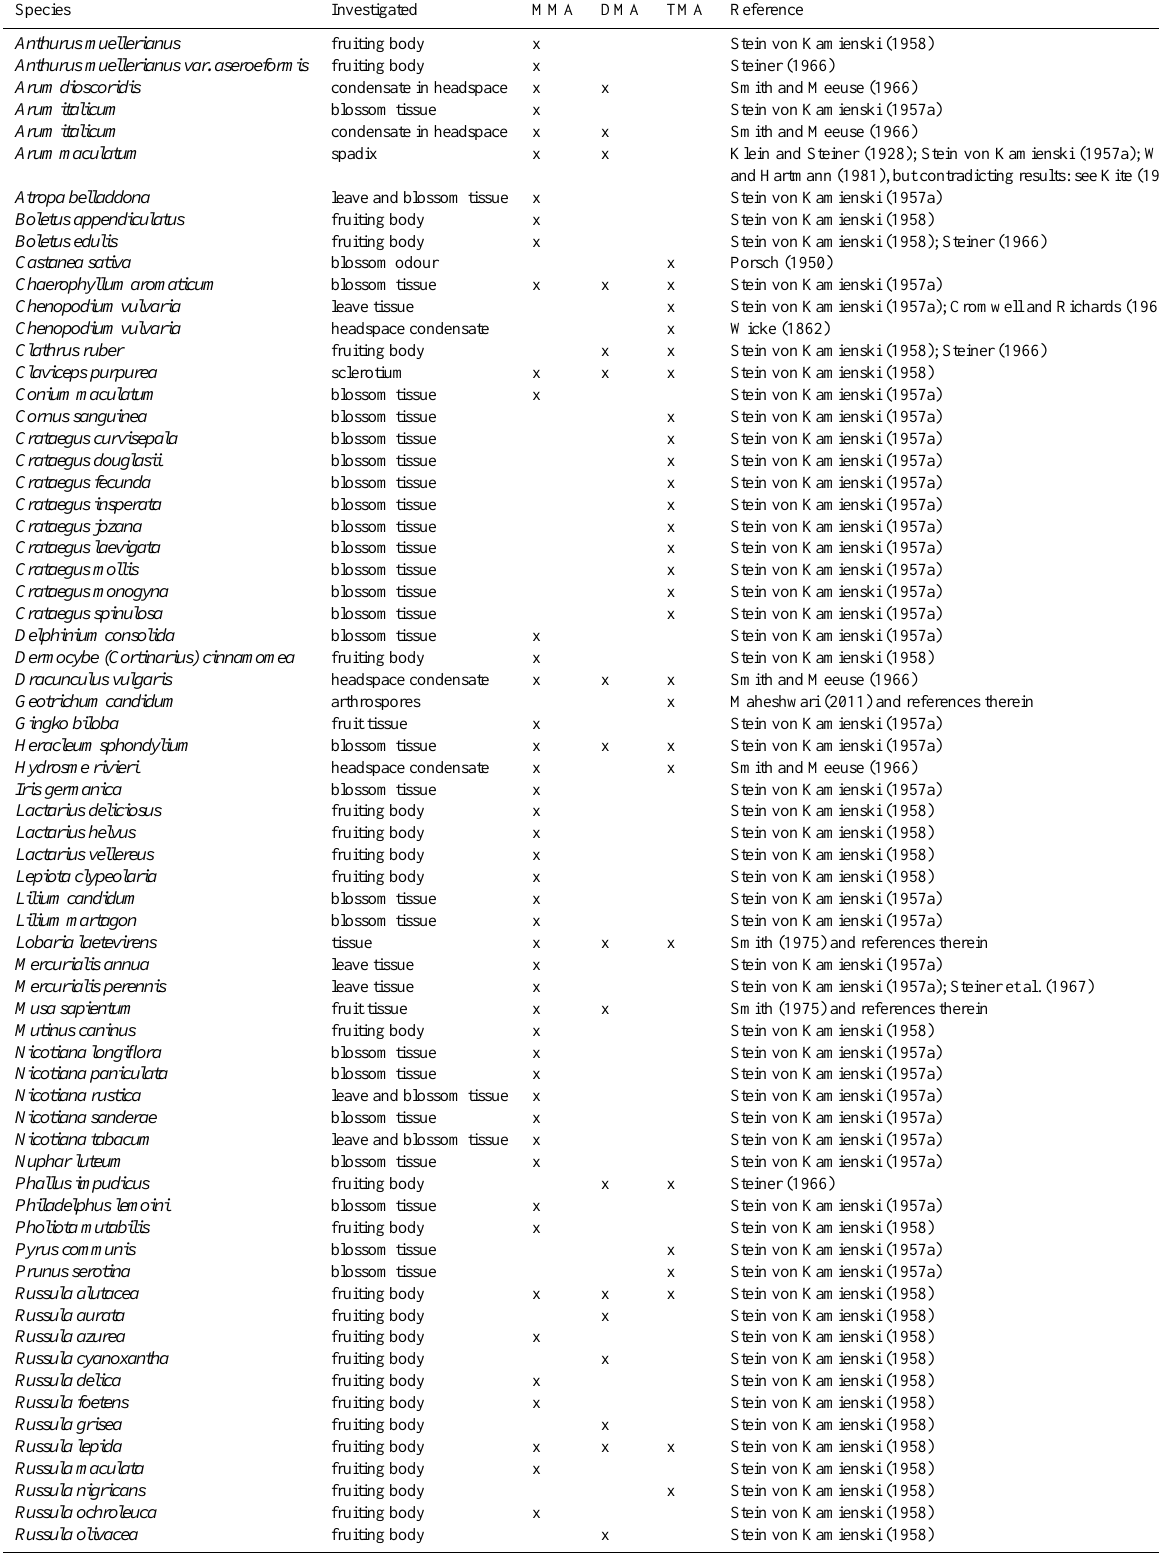
Table A1. Literature compilation of MA-enriched species (for another list see Duke and Williams, 1977). Bouchereau et al. (2000) discuss possible measurement uncertainties of amines in plant materials. Some of the older measurements listed in this table might be uncertain due to measurement